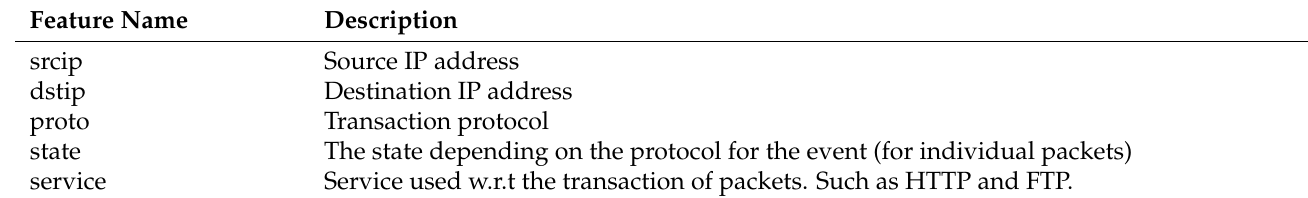
Table 1. Nominal features.